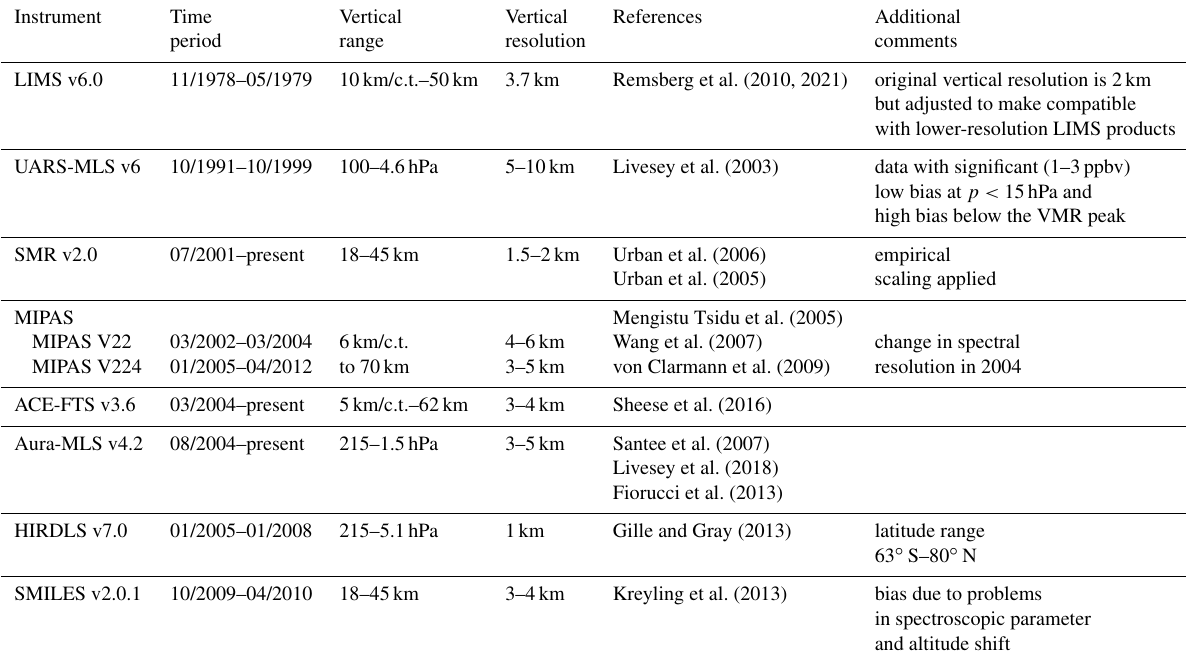
Table 15. Time period, vertical range, vertical resolution, references, and other comments for HNO 3